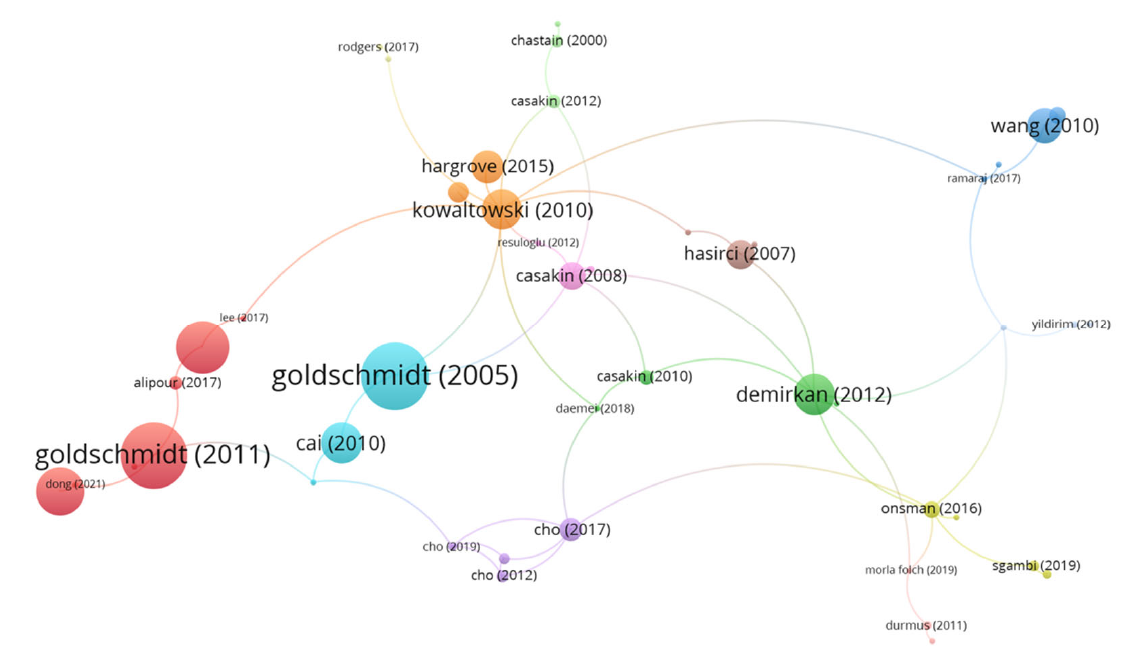
Figure 3. Mapping of authors’ collaboration network .